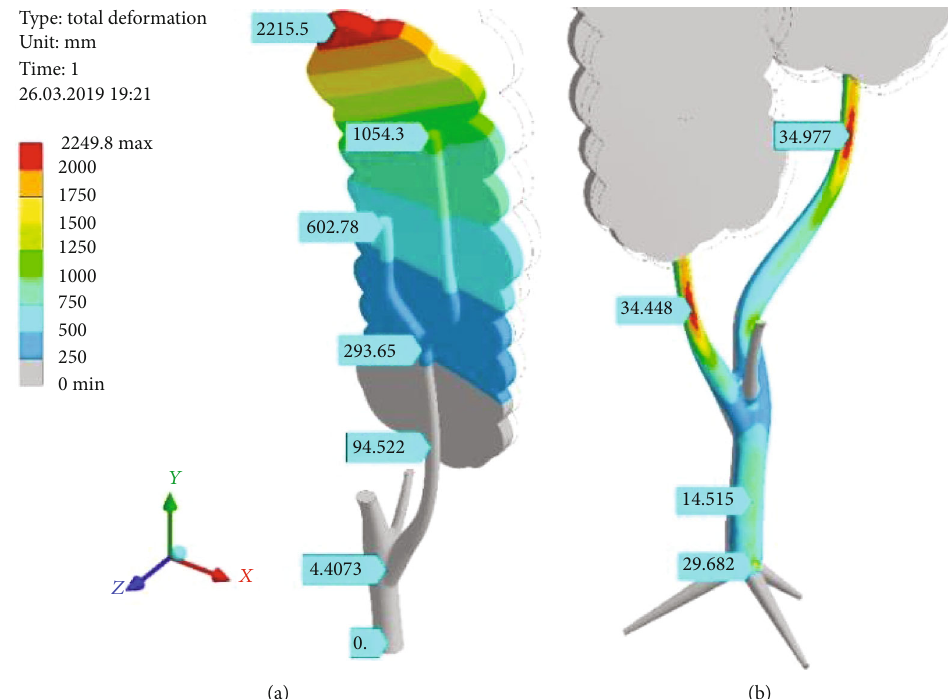
= 380 Pa) (a) and the picture of norm